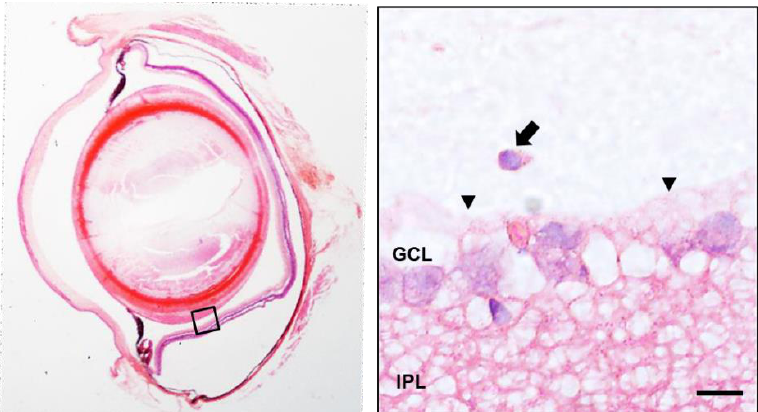
Figure 5. Localization of intravitreal cells (arrow) close to the internal limiting membrane (arrowhead) in hypertensive rat eyes. GCL: ganglion cell layer; IPL: internal plexiform layer. Scale bar: 12.5 µm.